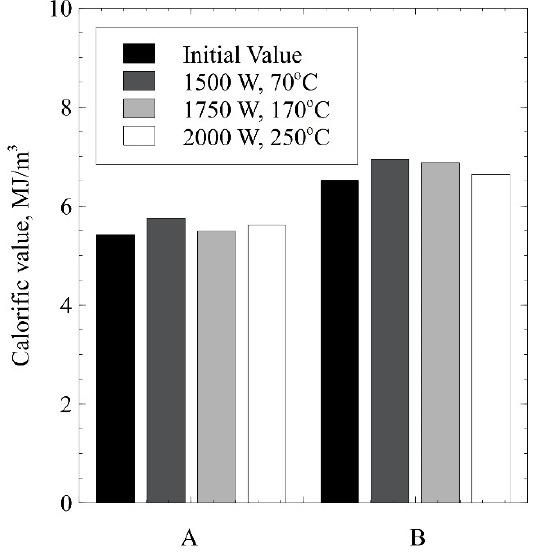
Figure 4. Effect of temperature and discharge power on calorific value for 4500 ppm initial C 7 H 8 concentration in the plasma–catalytic system with NiO/(CaO-Al 2 O 3 ) catalyst.